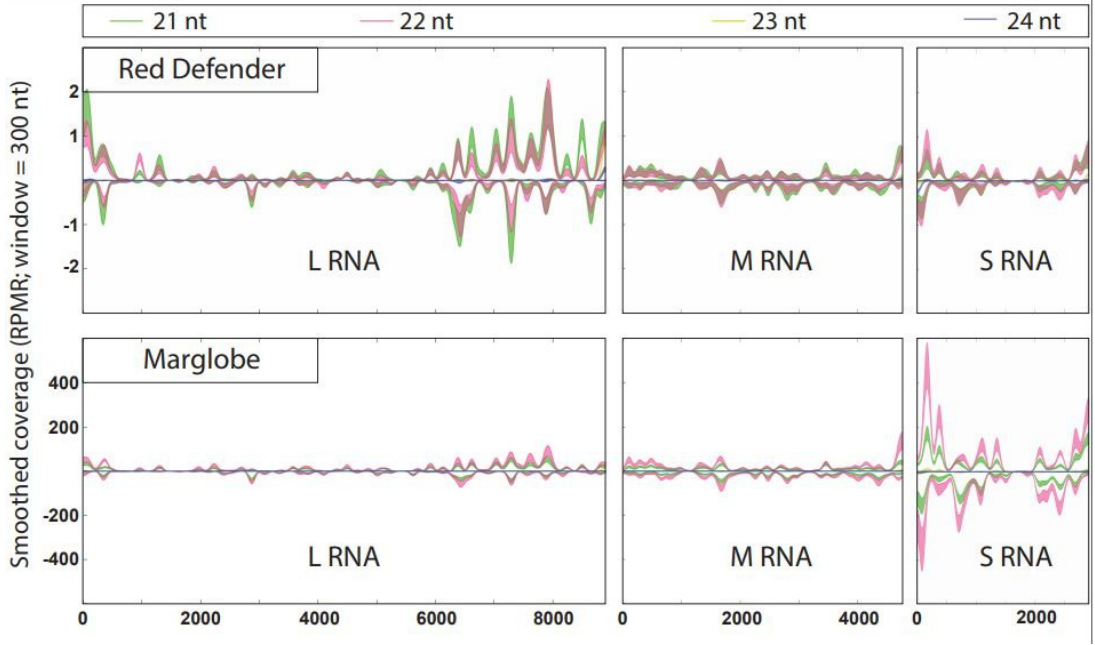
Figure 3. vsiRNAs profiles showing hotspots and corresponding regions in the tomato spotted wilt virus (TSWV) genomic RNAs in Sw -5(+) and Sw -5(−) varieties. The smoothed plots are standard error for each nucleotide size/alignment (i.e., the wider the red or green line, the greater the standard error of the 3 biological replicates at that position). The reads-per-million-reads (RPMR) scale for Red Defender is ±2.5 and for Marglobe is ± 400.